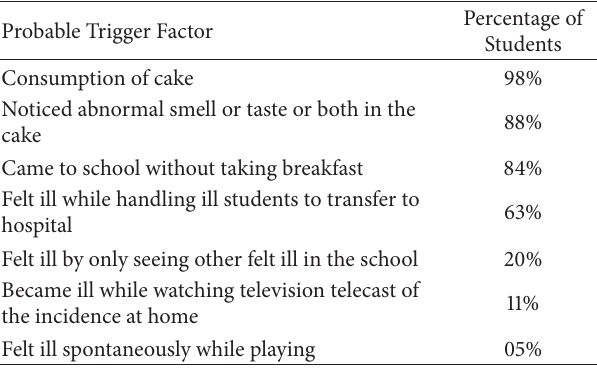
Table 3: Symptoms profile of ill students ( 𝑛 = 93 ).